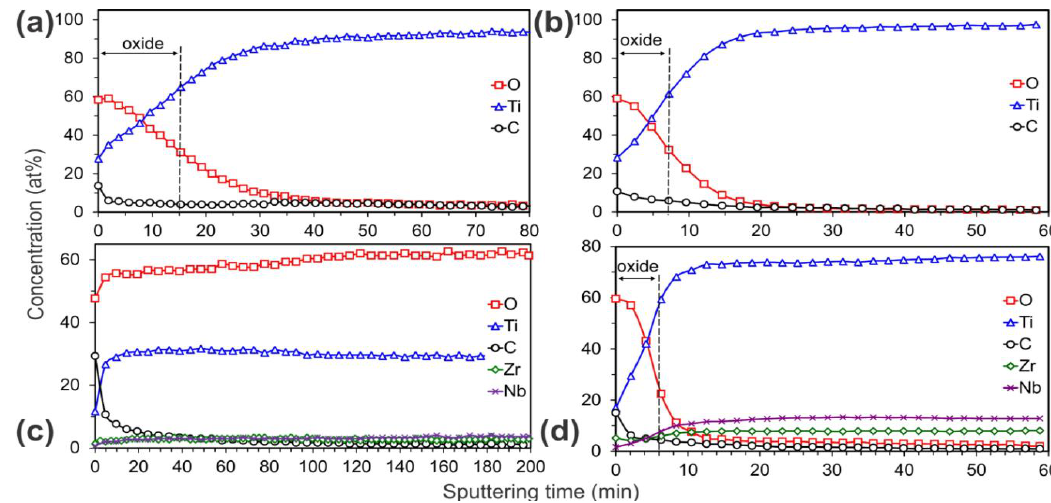
Figure 3. Auger electron spectroscopy (AES) profiles of the coatings on the samples: ( a ) Ti-A; ( b ) Ti-B; ( c ) TNZ-C; and ( d ) TNZ-D (etching rate: 2 nm/min). The thickness of the TiO anatase is indicated in each case. 2